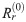
Feature selection on the MNIST dataset using the combinatorial Laplacian score.Each sample consists of a grey-scale image of a hand-written digit from 0 to 9 and each pixel represents a feature. The degree of localization of each feature in the simplicial complex is assessed using the 0- and 1-dimensional combinatorial Laplacian scores. (a) Number of rejected null hypothesis at a FDR of 0.05 as a function of the radius ε of the balls in the Vietoris-Rips complex. In this example, the statistical power of Rr(0) and Rr(1) is maximized for ε~0.7. The significance of the scores was determined through a permutation test were the pixels were randomized 5,000 times. (b) Vietoris-Rips complex colored by the intensity of a pixel that is significant under Rr(0) (q-value < 0.005) but not under Rr(1) (q-value = 0.5). The intensity of the pixel is high in a densely connected, topologically trivial region of the complex containing images of the digit `4`. Images associated to several nodes are shown for reference, with the pixel highlighted in red. (c) Vietoris-Rips complex colored by the intensity of a pixel that is significant under both Rr(0) (q-value < 0.005) and Rr(1) (q-value < 0.005). The intensity of the pixel is high in a densely connected region that surrounds a large non-contractible cycle of the simplicial complex. The cycle is generated by images that belong to the sequence of digits `7`, `3`, `1`, `9`. Images associated to several nodes along the cycle are shown for reference, with the pixel highlighted in red.